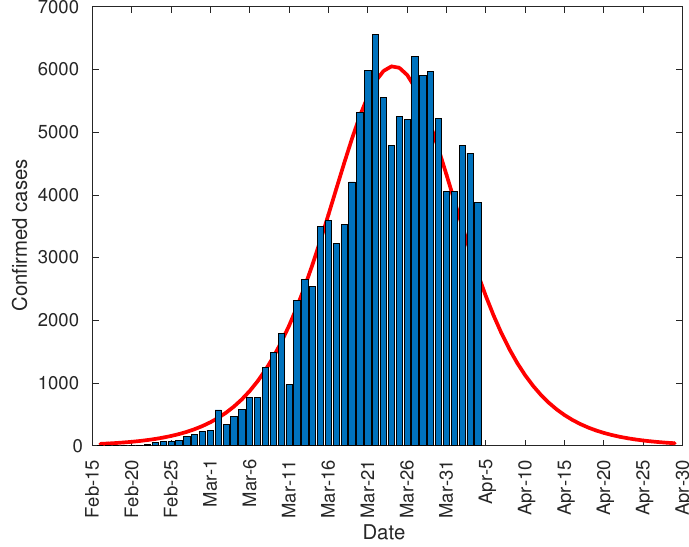
Figure 9. Number of daily diagnosed cases in